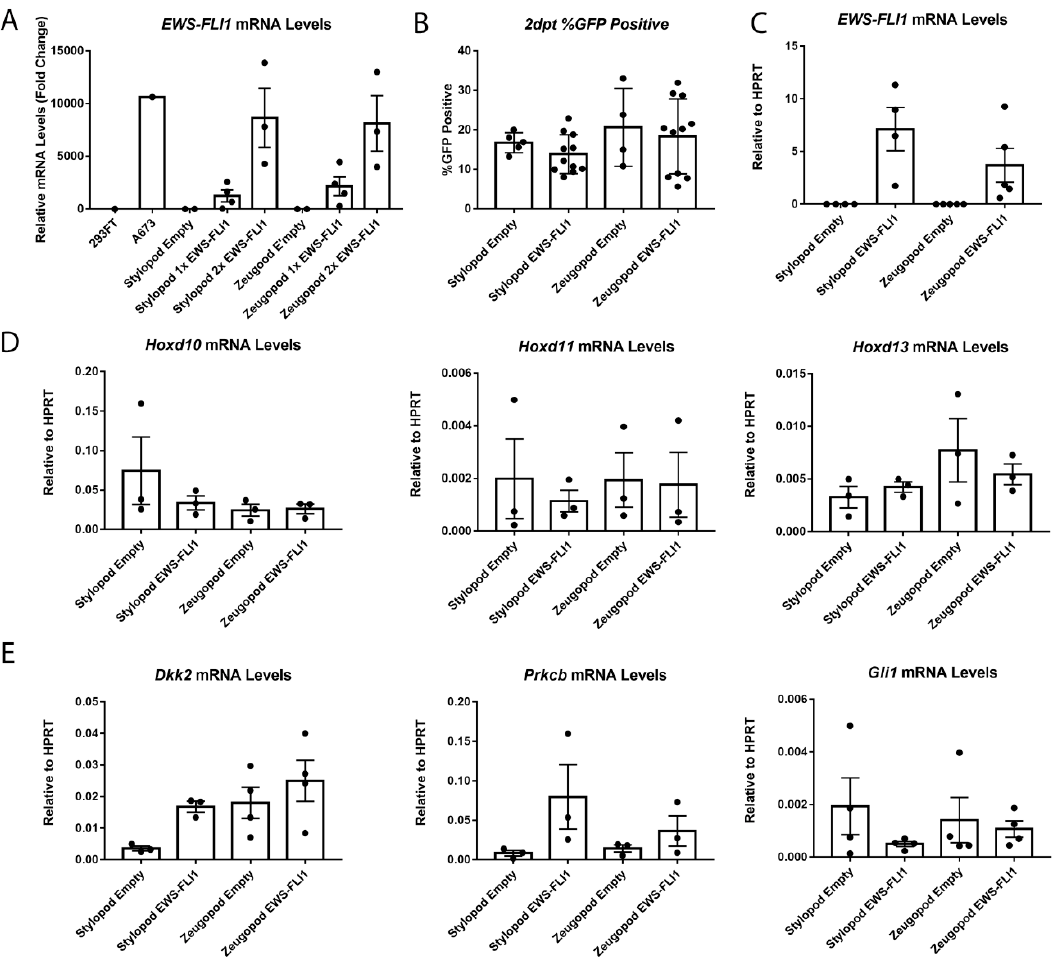
Figure 3. Stylopod and zeugopod eSZs undergo equivalent EWS-FLI1 transduction at two days post transduction (2 dpt). ( A ) Relative levels of EWS-FLI1 expression with increasing doses of EWS-FLI1 lentivirus. A673 is human Ewing sarcoma cell line for comparison. ( B ) Flow cytometry for GFP in transduced eSZs. ( C ) EWS-FLI1 mRNA levels relative to HPRT . ( D ) Hoxd10 , Hoxd11 , and Hoxd13 mRNA levels relative to HPRT . ( E ) Dkk2 , Prkcb , and Gli1 mRNA levels relative to HPRT . Error